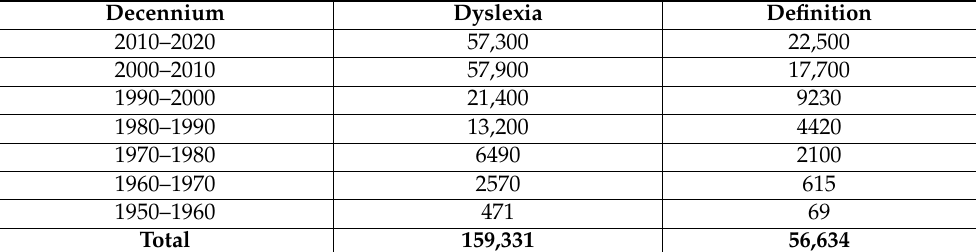
Table 2. Counts, publications on search words: “Dyslexia” and “Dyslexia Definitions”.